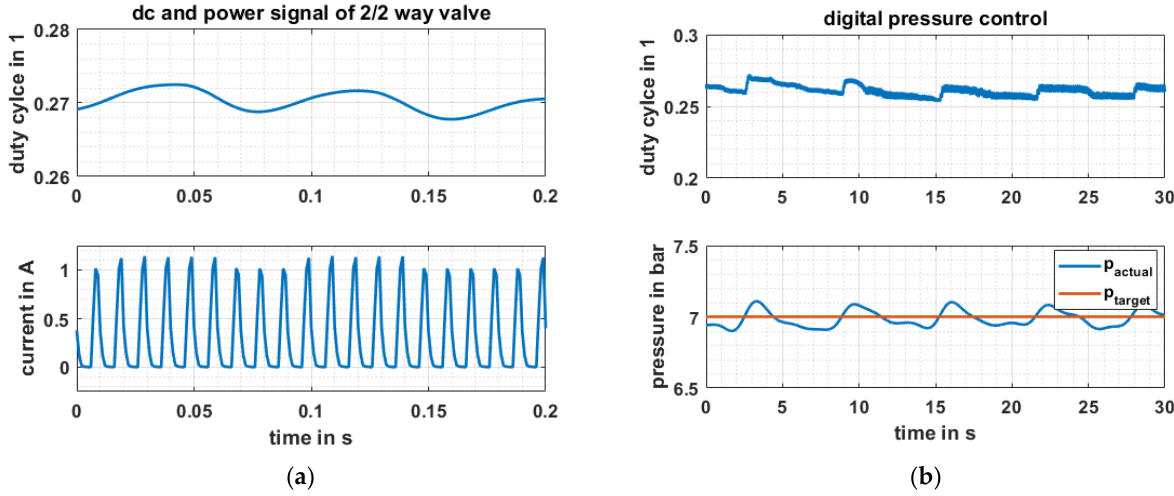
Figure 22. The DPC can be used whenever there is a sort of capacity on the pressure side. ( a ) power signal of a boosted 2-2-way seat valve; ( b ) graph of a pressure control including target and actual pressure.